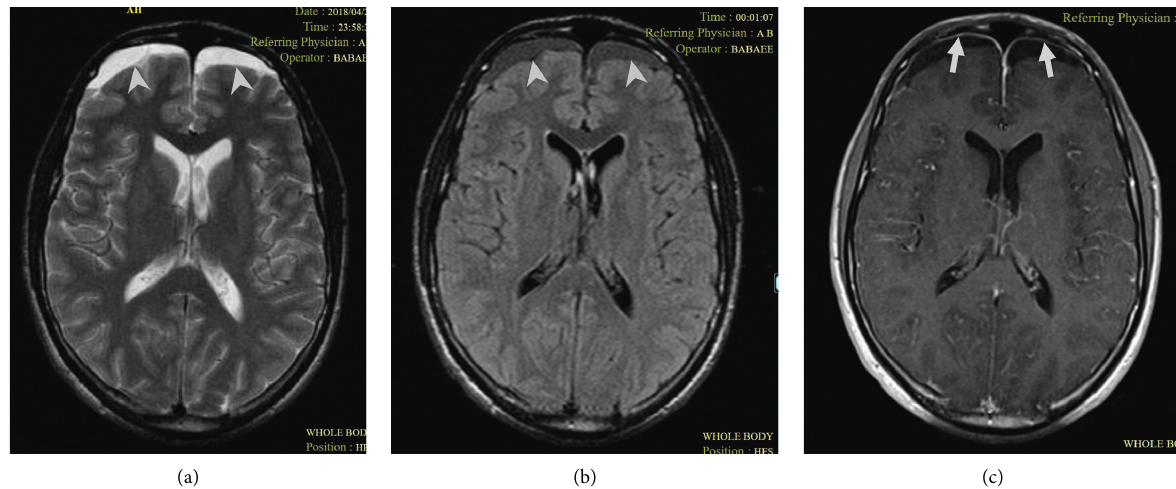
Figure 1: Brain magnetic resonance imaging indicative of bilateral subdural effusion (arrowheads in (a, b)) and diffuse leptomeningeal enhancement predominantly on the anterior surface of both hemispheres (arrows in (c)).